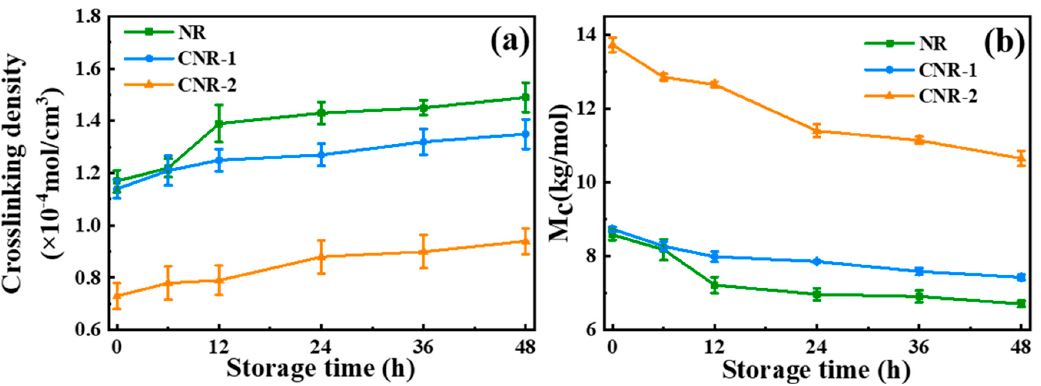
Figure 5. The variation of crosslinking density ( a ) and the average molecular weight between crosslinking (M c ) ( b ) of NR, CNR-1, and CNR-2 before and after accelerated storage.